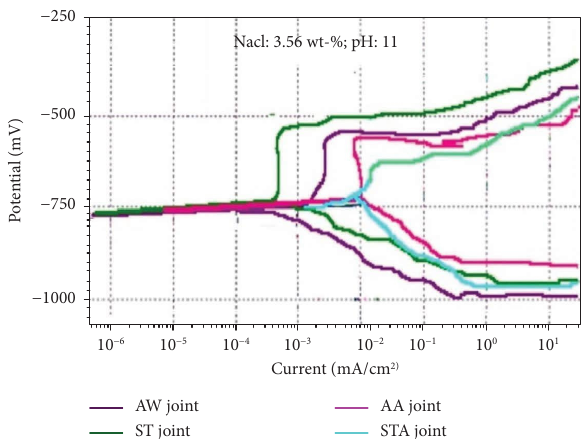
Figure 13: Tafel plot of welded joints in 3.56wt.% NaCl solution having a pH of 11.